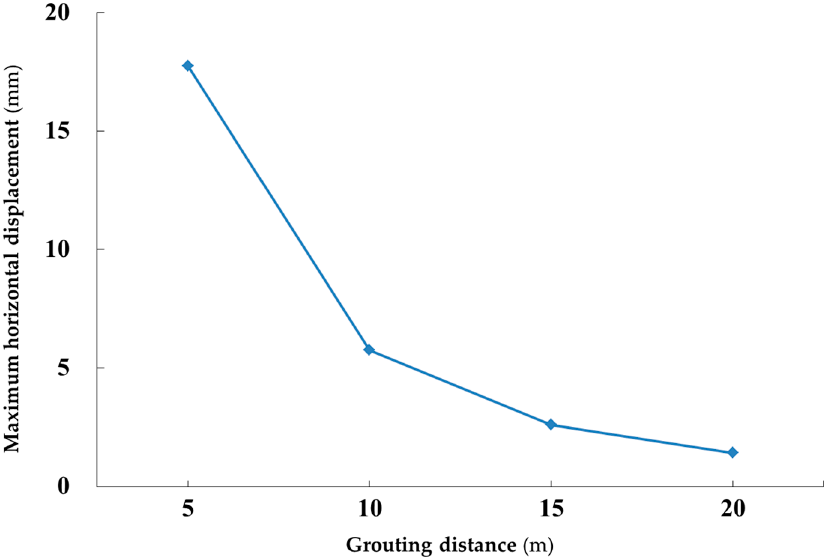
Figure 12. The relationship between the grouting distance and the maximum horizontal displacement of the tunnel.